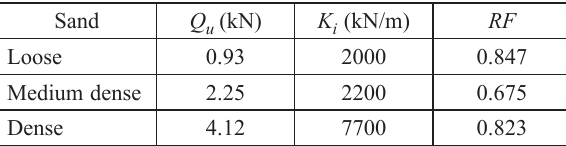
Table 5. Back-calculated parameters in Eqn (4) for all sand densities